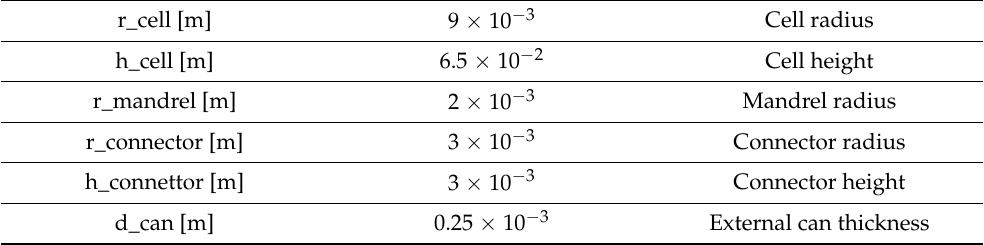
Table 2. Two-dimensional cell component size.